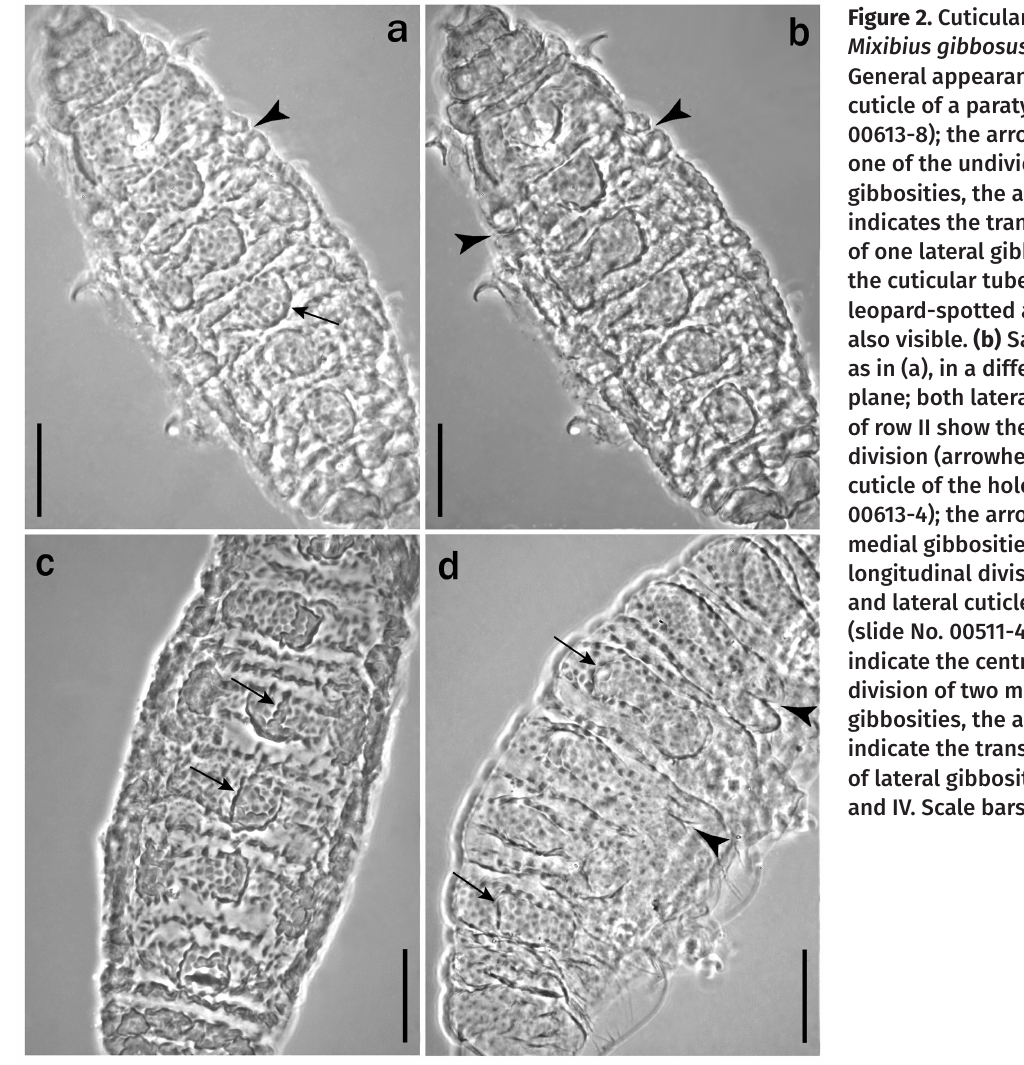
Figure 2. Cuticular structures of Mixibius gibbosus sp. nov. (a) General appearance of the dorsal cuticle of a paratype (slide No. 00613-8); the arrow indicates one of the undivided medial gibbosities, the arrowhead indicates the transverse division of one lateral gibbosity of row II; the cuticular tubercles giving a leopard-spotted appearance are also visible. (b) Same paratype as in (a), in a different focal plane; both lateral gibbosities of row II show the transverse division (arrowheads). (c) dorsal cuticle of the holotype (slide No. 00613-4); the arrows indicate two medial gibbosities with central longitudinal division. (d) dorsal and lateral cuticle of a paratype (slide No. 00511-4); the arrows indicate the central longitudinal division of two medial gibbosities, the arrowheads indicate the transverse division of lateral gibbosities of rows II and IV. Scale bars are all 20